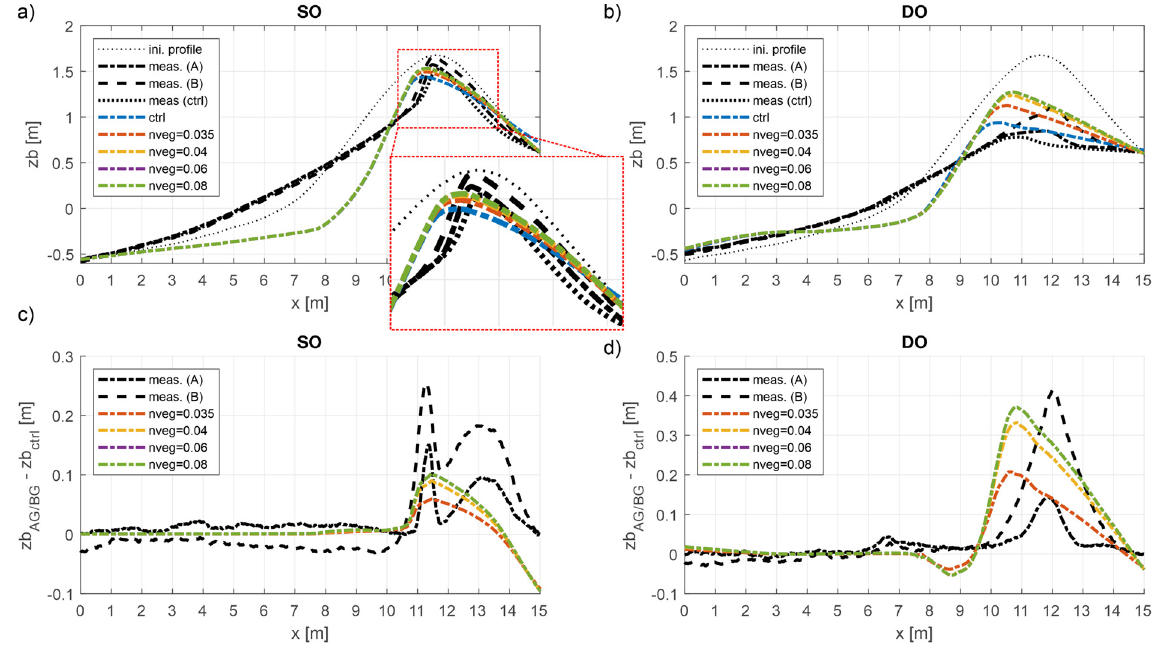
Figure 6. Modeling overwash conditions with belowground biomass: Comparison of initial (thin dotted), final measured control (thick dotted, black) and final measured BG (dashed, black) and AG (dash-dotted, black) dune profiles with simulation results (dash-dotted), including the control simulation (blue) and the application of spatially increased friction coefficients (color) for shallow overwash ( a ) and deep overwash ( b ). Profile differences (belowground to control) are shown for the measurements (dashed) and the simulations (dash-dotted) for shallow ( c ) and deep collisions ( d ). Note : Overlay of the purple and green lines.